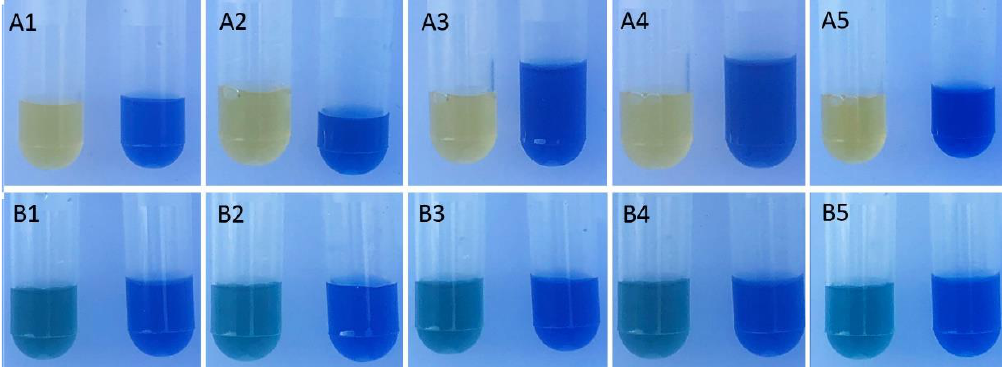
Figure 3. N- fixation ability of five strains was determined by inoculating 10 μL bacterial resuspension to the test tube containing 5 mL of the N-free malate broth with different pH, and then observing the color change in the test tubes after incubation at 30 °C in a rotary shaker at 180 rpm for 2 d. Bacterial resuspensions were prepared by resuspending bacteria grown in nutrient broth in the N-free malate broth and then adjusting the cell density to 10 7 cfu/mL. ( A ). pH 5.0. ( B ). pH 7.0. 1–5: Strains ZJ3-12, ZJ5, ZJ9, ZJ62 and ZJ174. In each treatment, Control is on the left, strain is on the right.